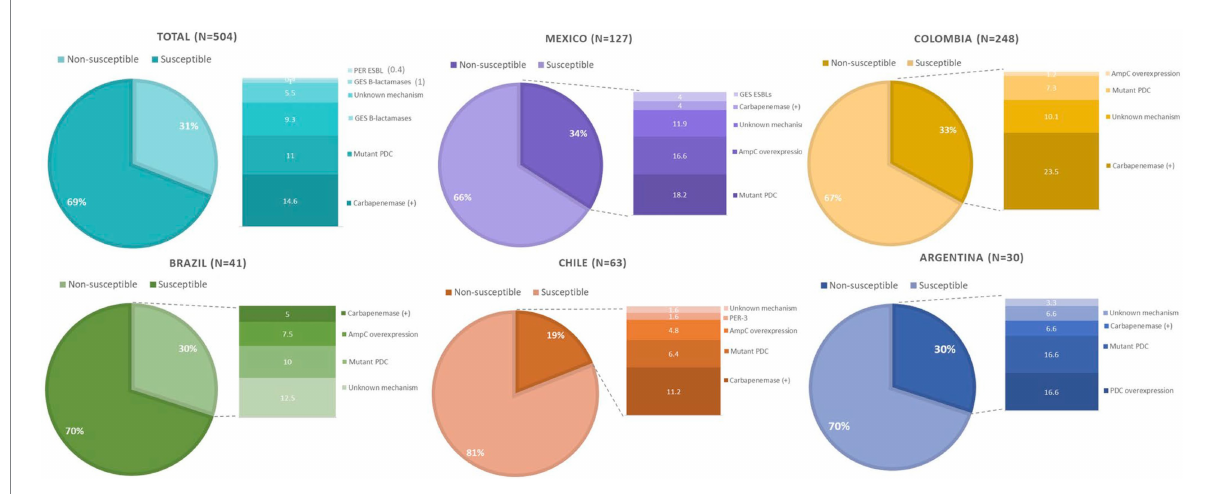
FIGURE 2 Overview of the molecular mechanisms leading to TOL resistance in clinical isolates of Pseudomonas aeruginosa collected in five Latin American